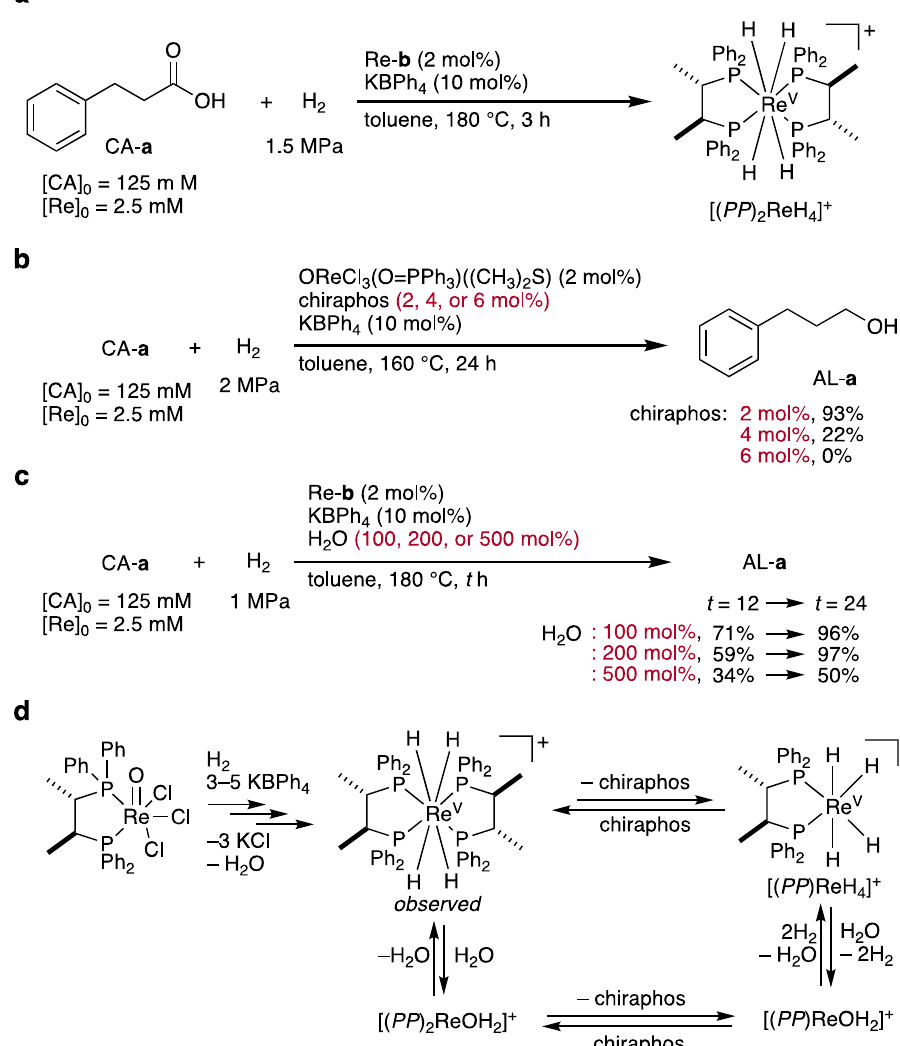
Figure 5. Control experiments to elucidate the structural change of Re-b in the presence of CA-a, H 2 , and K[BPh] 4 . ( a ) Predominant complex detected by ESI-MS: Re/(chiraphos) 2 . ( b ) Effect of the quantity of chiraphos on the reaction rate. ( c ) Effect of the quantity of water on the reaction rate. ( d ) Proposed structural changes 2